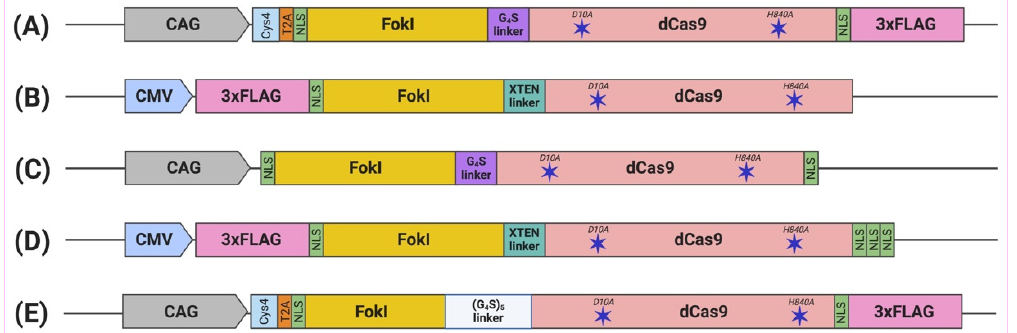
3 of 18 Figure 1. Illustrations of different genome engineering tools. ( A ) Zinc fingers nucleases (ZFNs) bind to the target sequence through 3-4 zinc finger proteins, and ( B ) transcription activator-like effector nucleases (TALENs) through repeat variable diresidues (RVDs), both of which inducing double- stranded breaks (DSBs) through heterodimerization and the catalytic activity of the fused FokI. ( C ) CRISPR – Cas9 binds to the DNA target through PAM sequences and the complementary sgRNA site,